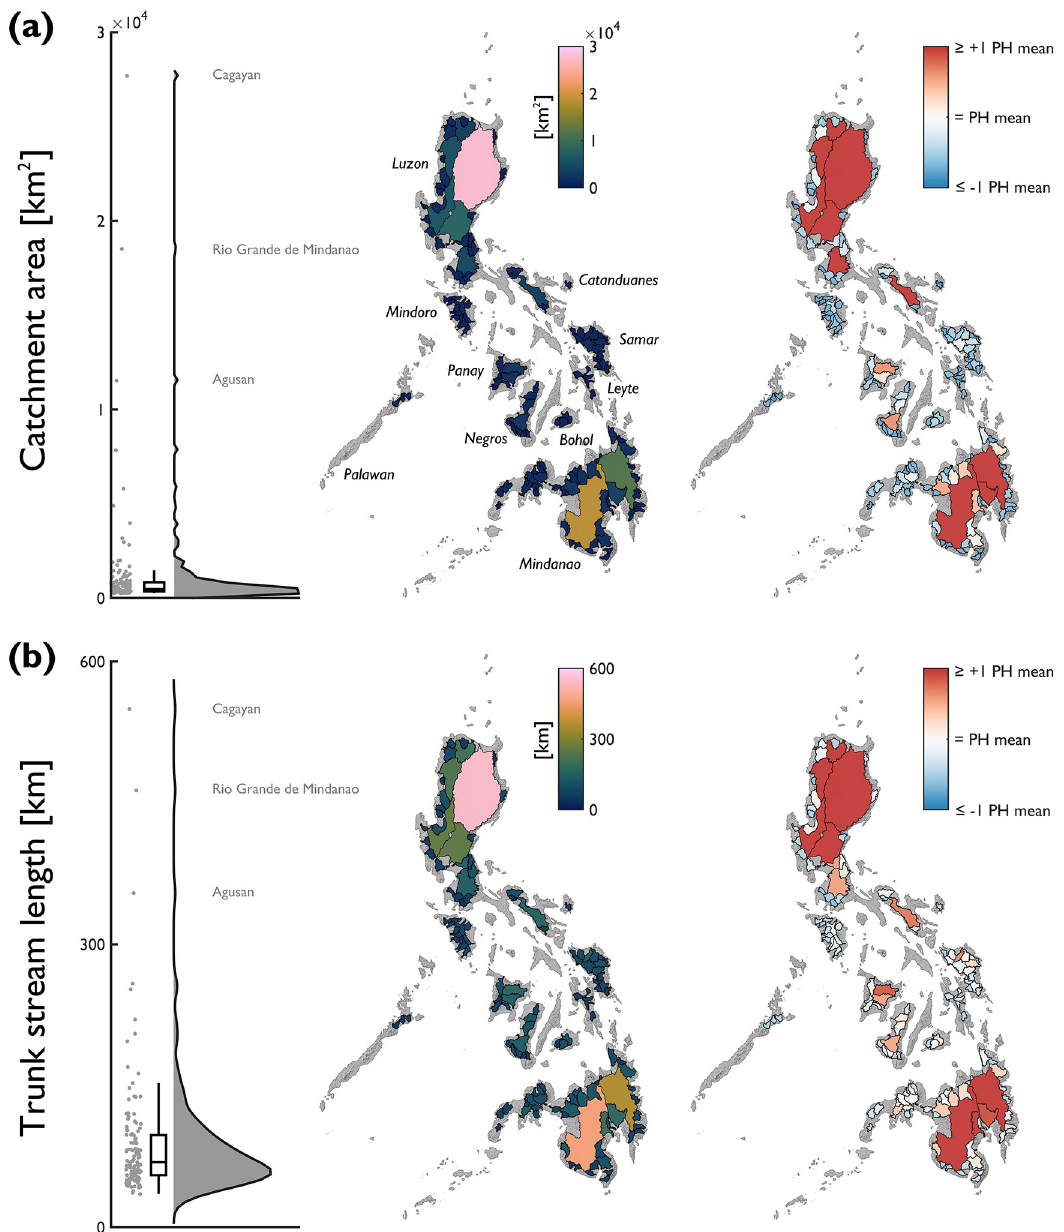
Fig 3. National-scale assessment of areal and linear characteristics expressed by: (a) catchment area; and, (b) trunk stream length. Note that for the red-blue choropleth map, values are displayed relative to the Philippine average for each attribute (catchment area = 1257 km 2 ; trunk stream length = 90 km). Annotations on the raincloud plots denote catchments with notably high/low